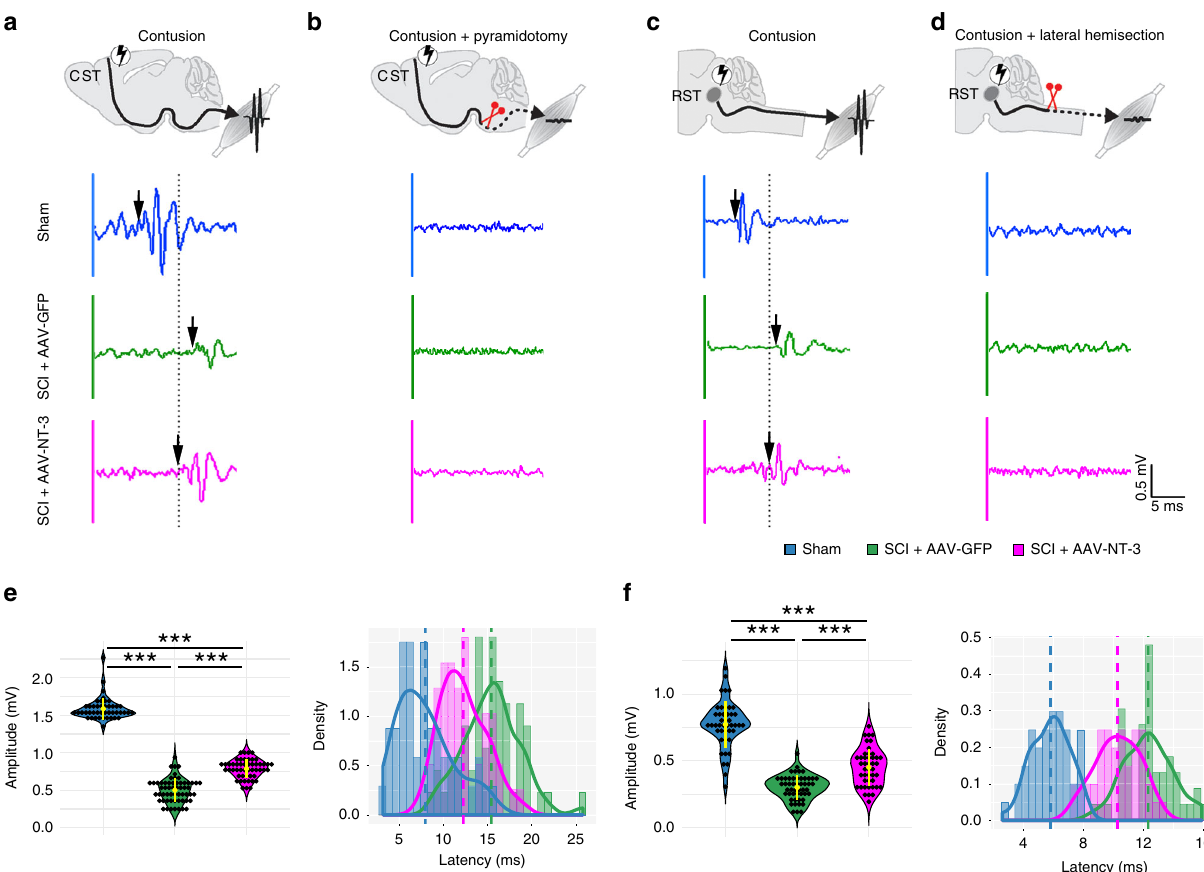
Fig. 2 NT-3 enhanced cortical and rubral control of hindlimb EMG response. a Schematic diagram shows EMG potentials recorded in contralateral gastrocnemius muscle in response to electrical stimulation in the motor cortex of mice at 6 weeks after a T9 contusion. Representative examples of EMG traces were evoked by motor-cortex stimulation in the sham, SCI + AAV-GFP, and SCI + AAV-NT-3 treatment groups after SCI. The dotted line indicates the onset of EMG response in an AAV-NT-3-treated mouse; the arrows indicate the EMG latency. b Schematic diagram illustrates EMG activity in each group at 1 day after bilateral pyramidotomy. c Schematic diagram shows EMG potentials recorded in the contralateral gastrocnemius muscle in response to electrical stimulation in the red nucleus of mice at 6 weeks after the T9 contusion. Representative examples of EMG traces were plotted for each animal group. d Schematic diagram illustrates the EMG activities in each animal group at 1 day following bilateral lateral hemisection to transect the RST at the C5 vertebral level. e Quantitative analysis of cortico-stimulation-induced EMG amplitudes and latencies of the sham (44 stimulation sites from 6 mice), SCI + AAV-GFP (57 stimulation sites from 8 mice), and SCI + AAV-NT-3 (50 stimulation sites from 7 mice) animal groups. f Quantitative analysis of rubro- stimulation-induced EMG amplitudes and latencies in the sham (44 stimulation sites from 5 mice), SCI + AAV-GFP (49 stimulation sites from 6 mice), and SCI + AAV-NT-3 (45 stimulation sites from 6 mice) animal groups. The black dots represent independent stimulation sites from each group. The yellow lines from violin plots indicate mean ± SD. The dashed lines in histograms indicate the mean line from each group. *** P < 0.001. One-way ANOVA followed by Tukey ’ s multiple comparison test. EMG electromyography, CST corticospinal tract, RST rubrospinal tract. Source data are provided as a Source Data fi